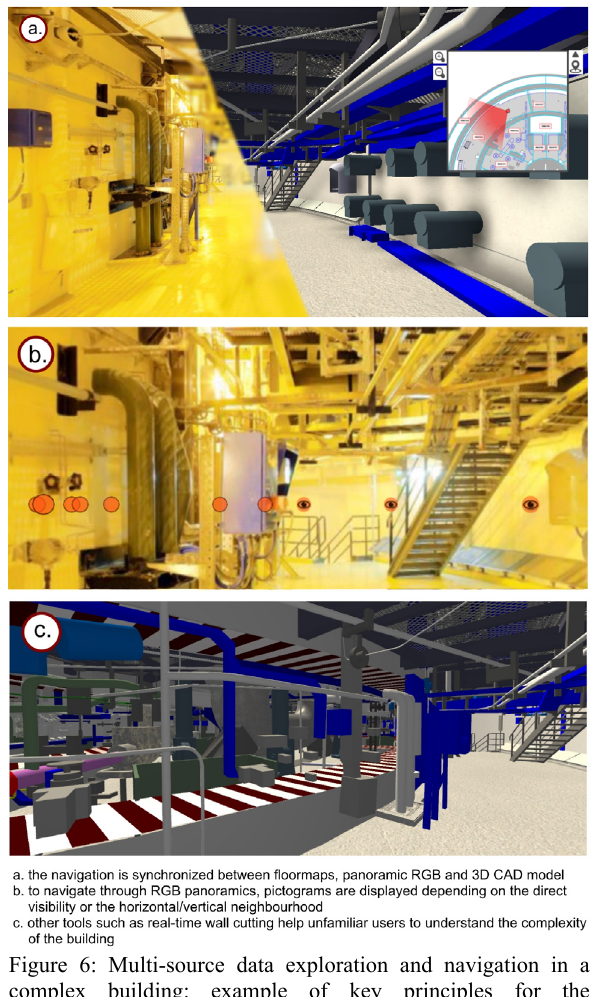
Figure 6: Multi-source data exploration and navigation in a complex building: example of key principles for the development of an